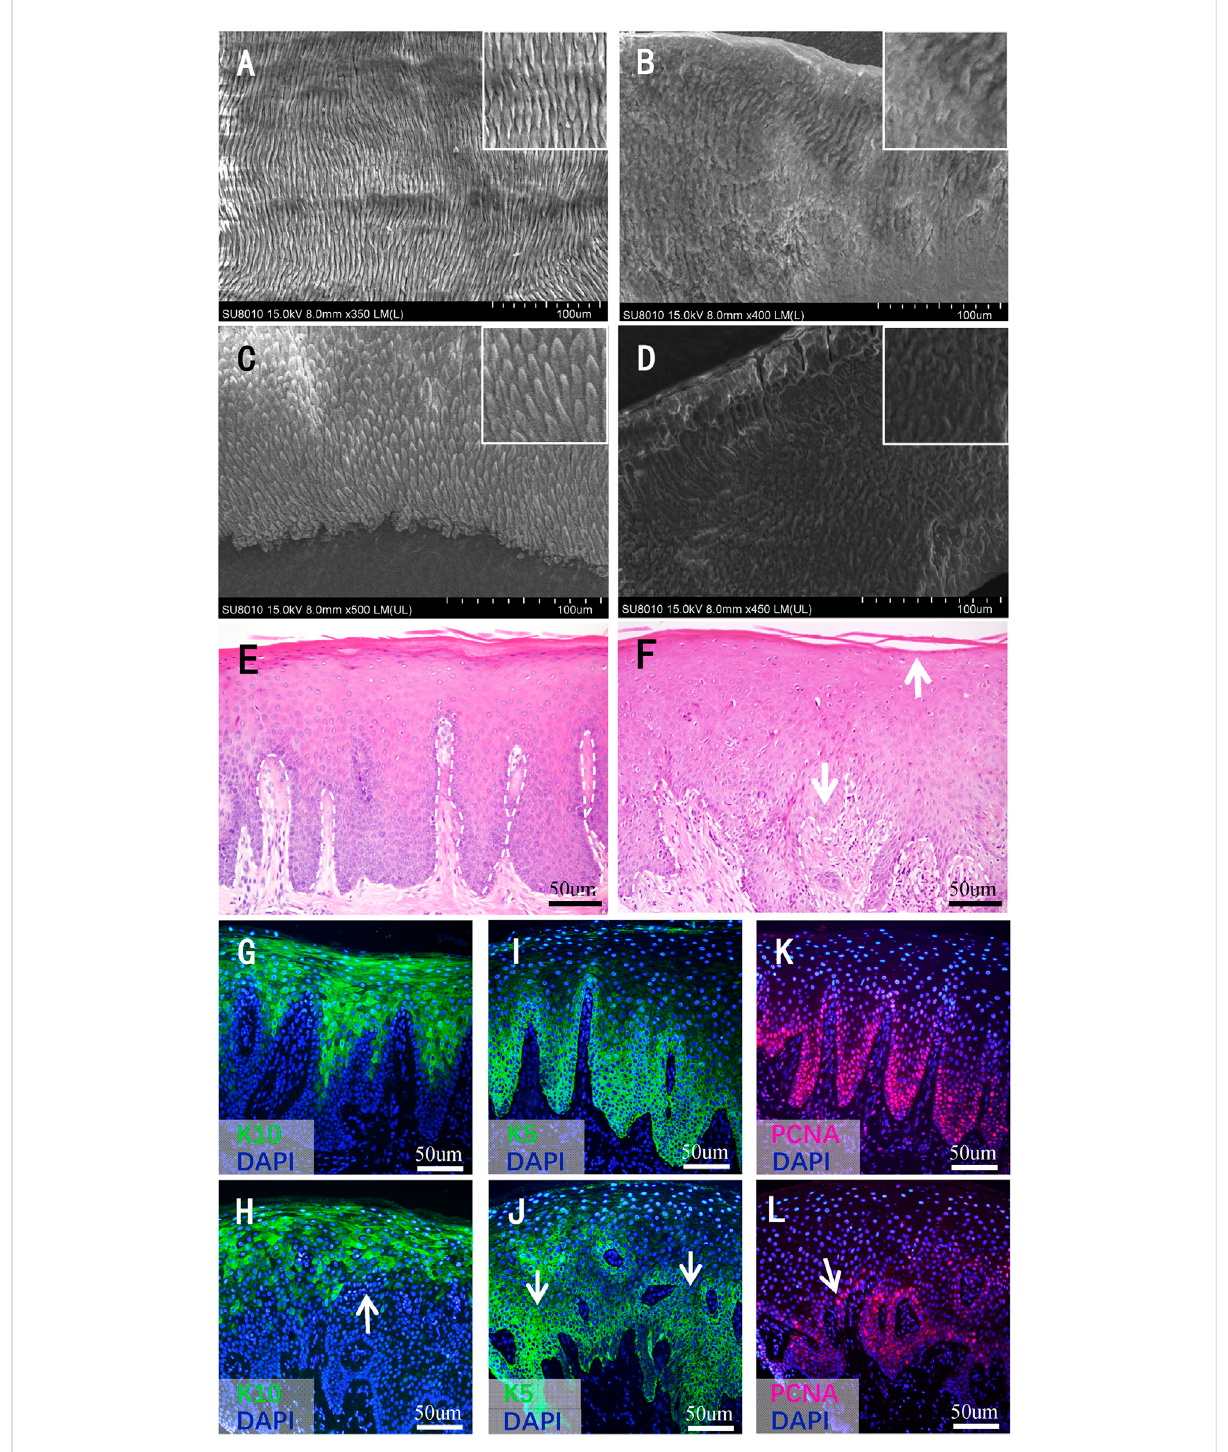
FIGURE 4 Histological fi ndingsofteethandgingivalmucosa. (A – D) Scanningelectronmicroscopyimagesoftheteeth. (A) Theenamelofanormalpermanentincisor and (B) affectedtooth32. (C) Theenamelofanormalprimarytoothand (D) affectedtooth63.Highermagni fi cationsofdentinaltubulesareshownintheinset. (E) Hematoxylin – eosin staining images of normal gingival mucosa and (F) the patient ’ s mucosa. The white dashed line indicates the boundary between the basal layerandtheunderlyinglaminapropria.Thewhitearrowsin (F) indicatethebrokenkeratinizedlayerandtheblurryboundarybetweenthebasallayerand laminapropria,respectively. (G – L) Immuno fl uorescence(IF)stainingimagesofnormalgingivalmucosaandthepatient ’ smucosa. (G) IFstainingofK10ofnormal mucosaand (H) thepatient ’ smucosa. (I) IFstainingofK5ofnormalmucosaand (J) thepatient ’ smucosa. (K) IFstainingofPCNAofnormalmucosaand(L)thepa- tient ’ s mucosa. The white arrows in (H – L) indicate the disperse and irregular expression range.